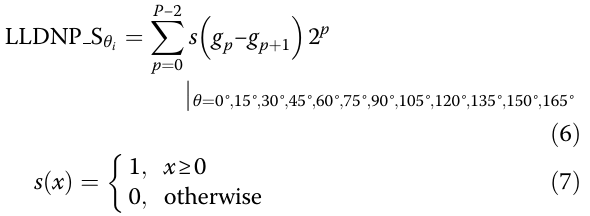
Table 1 Performance of the proposed method with various window sizes on Brodatz database